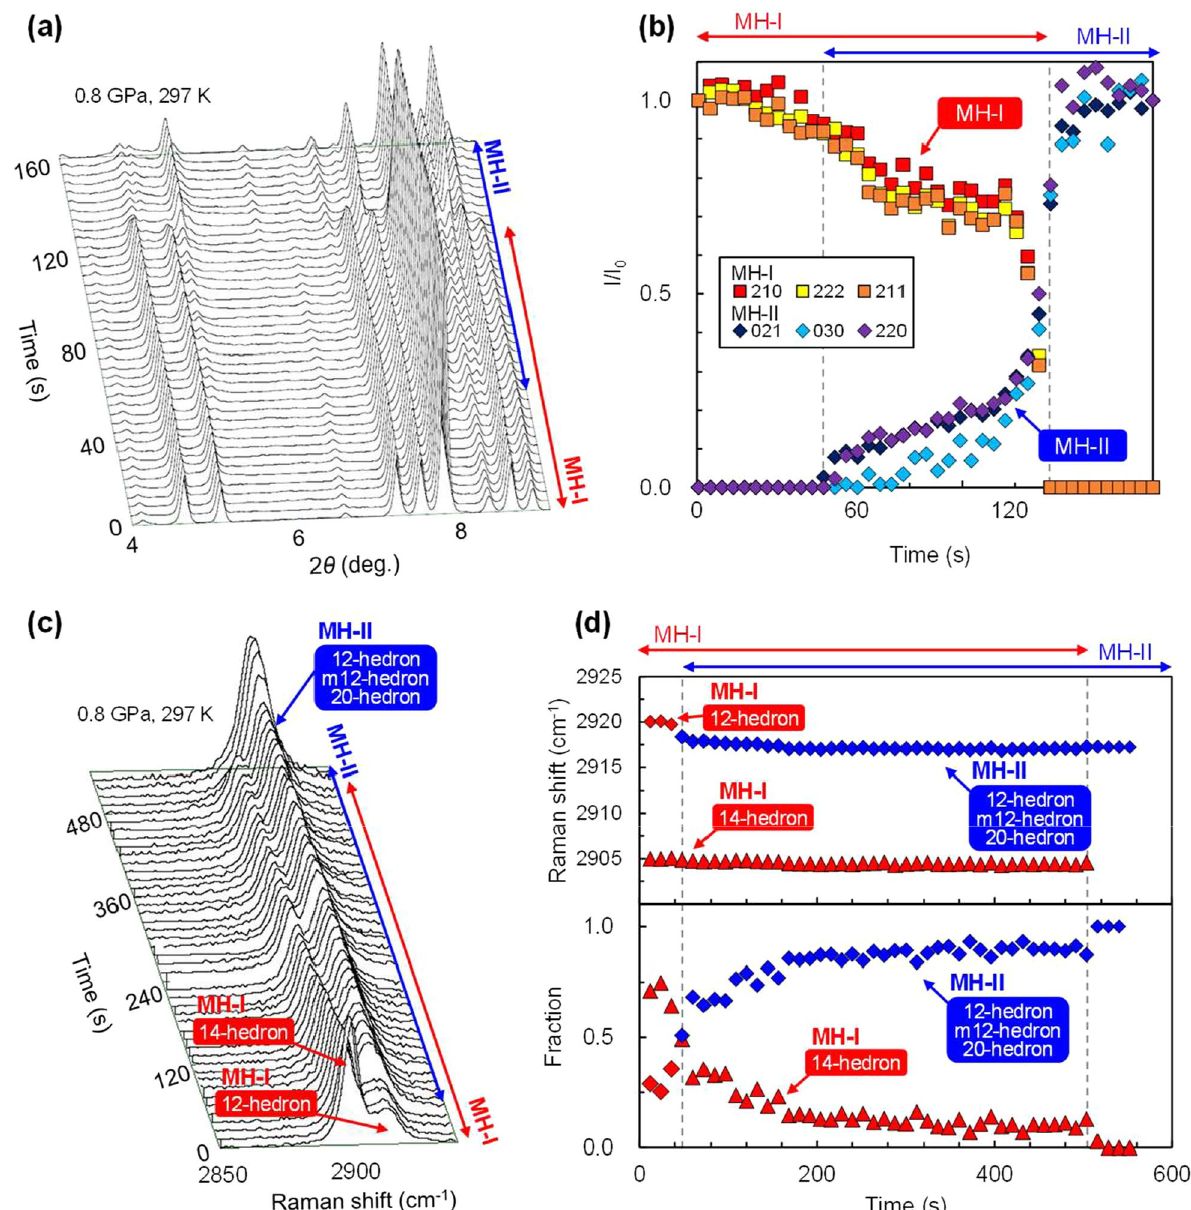
Fig. 2 Progression of the phase change from MH-I to MH-II as described by changes in the host structure and vibrational modes of the guest over time. a Time-resolved XRD patterns and b relative intensity of the representative diffraction lines of MH-I and MH-II. c Time-resolved Raman spectra of vibration modes and d (top) Raman shift and (bottom) fraction of methane molecules in each cage in MH-I and MH-II. The 12-hedra in MH-I are preserved in the following MH-II structure, and the 14-hedra of MH-I are recombined into 12-hedra, modified 12-hedra, and 20-hedra in MH-II. This figure is modified from Hirai et al.